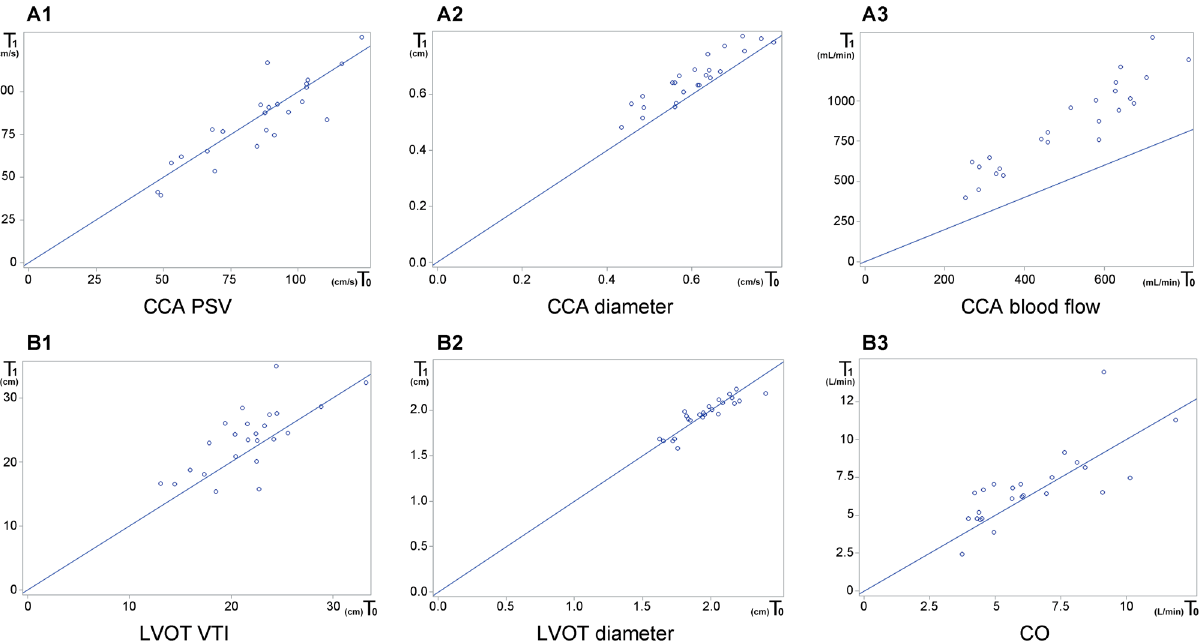
Figure 2. Scatter plot of carotid POCUS and TTE before (T 0 ) and after (T 1 ) restoration of a MAP ≥ 65 mmHg with norepinephrine in the whole population (n = 24) : A1 (CCA PSV), A2 (CCA diameter), A3 (CCA blood flow), B1 (LVOT VTI), B2 (LVOT diameter), B3 (CO). POCUS, point-of-care ultrasound; TTE, transthoracic echocardiography; MAP, mean arterial pressure; CCA, common carotid artery; PSV, peak systolic velocity; LVOT, left ventricular outflow tract; VTI, velocity time integral; CO, cardiac output The lines in each graph represent the same unit values on the X (T 0 ) and Y (T 1 ) axes.